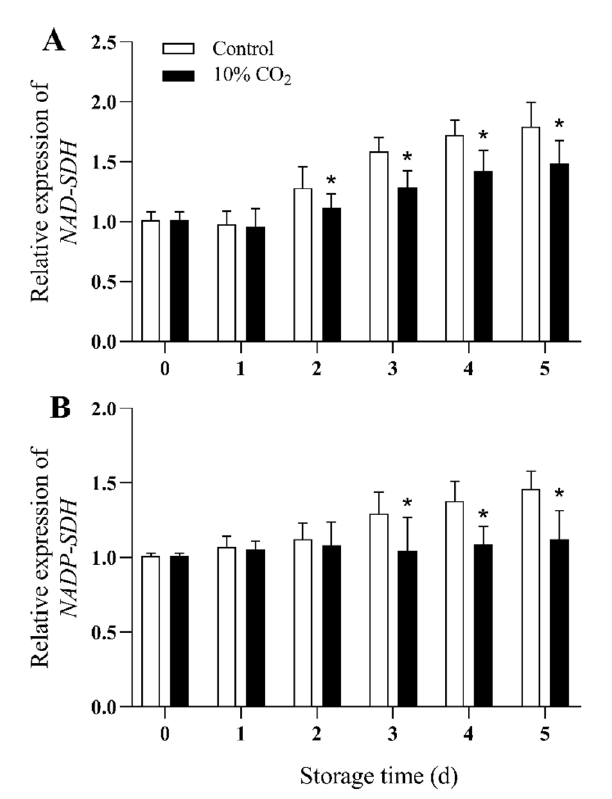
Figure 6. Effect of CO 2 on gene expression levels of NAD-SDH ( A ), and NADP-SDH ( B ) of fresh-cut pear fruit during storage. Values are presented as means ± SD ( n = 9). Asterisks (*) indicate significant differences at the same time between controls and CO 2 -treated fruit according to the Student’s-test ( p < 0.05)